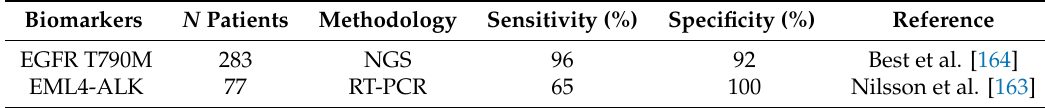
Table 4. Principal clinical biomarkers detectable by